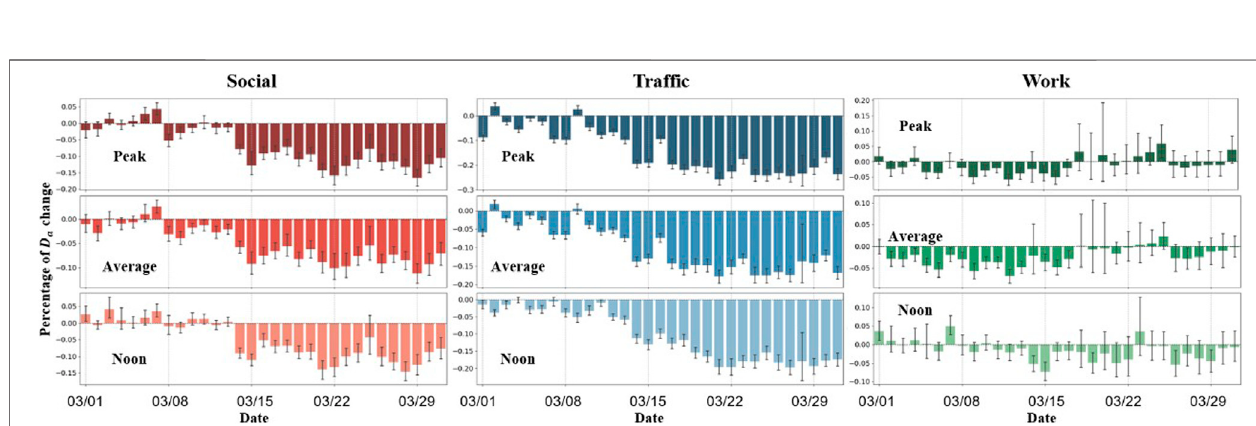
FIGURE 4 | The percentage change of D a for 193 counties in March 2020. The height of each bar is the average percentage change of all 193 counties, and the error bar indicates the standard deviation among all counties. The three tile categories of social, traf fi c, and work are shown in each column, and three daily tile aggregations of peak, average, and noon are shown in each